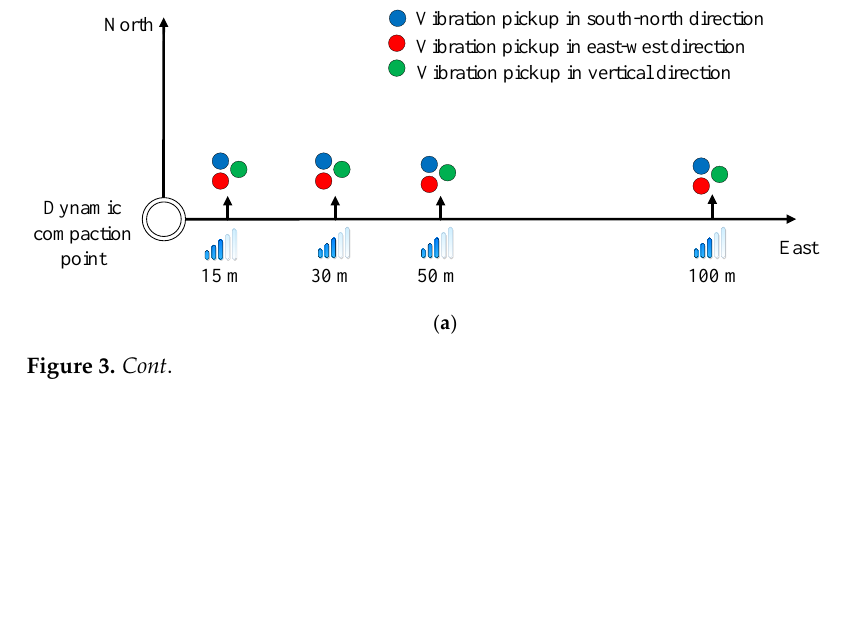
Figure 2. Testing devices used in the test.